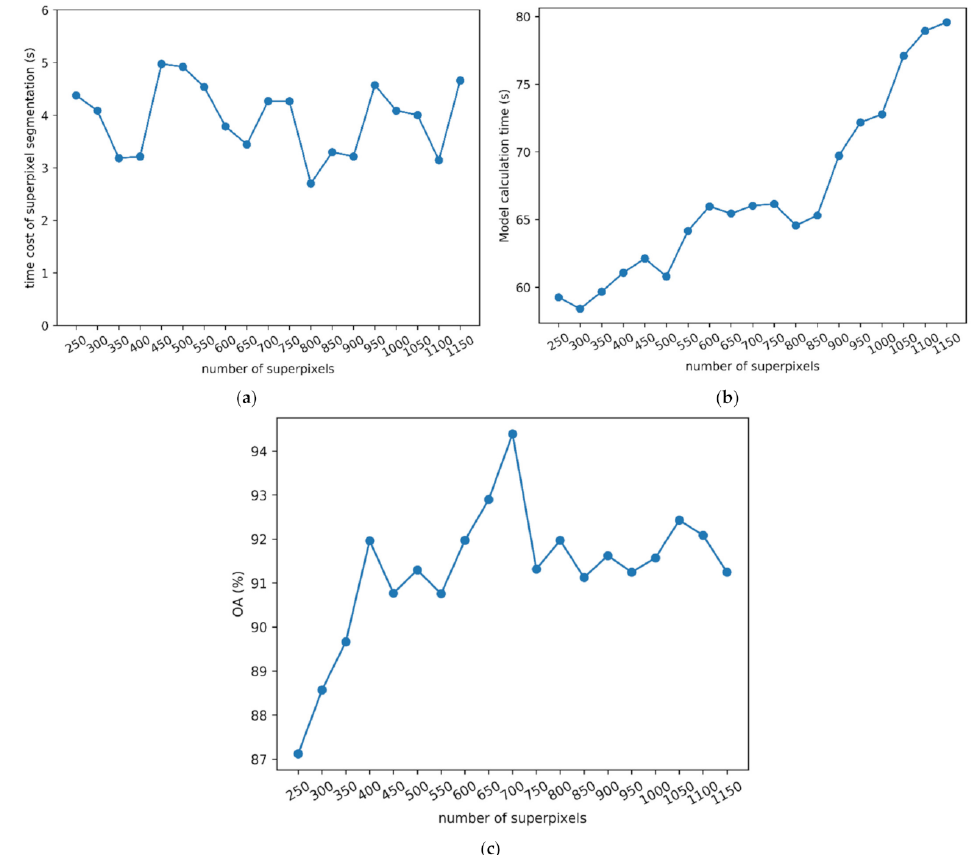
Figure 17. Impact of the Number of Superpixels. ( a ) The time cost of superpixel segmentation for deferent superpixel number; ( b ) MFEGCN-FSAM calculation time for deferent superpixel number; ( c ) MFEGCN-FSAM classification OA for deferent superpixel